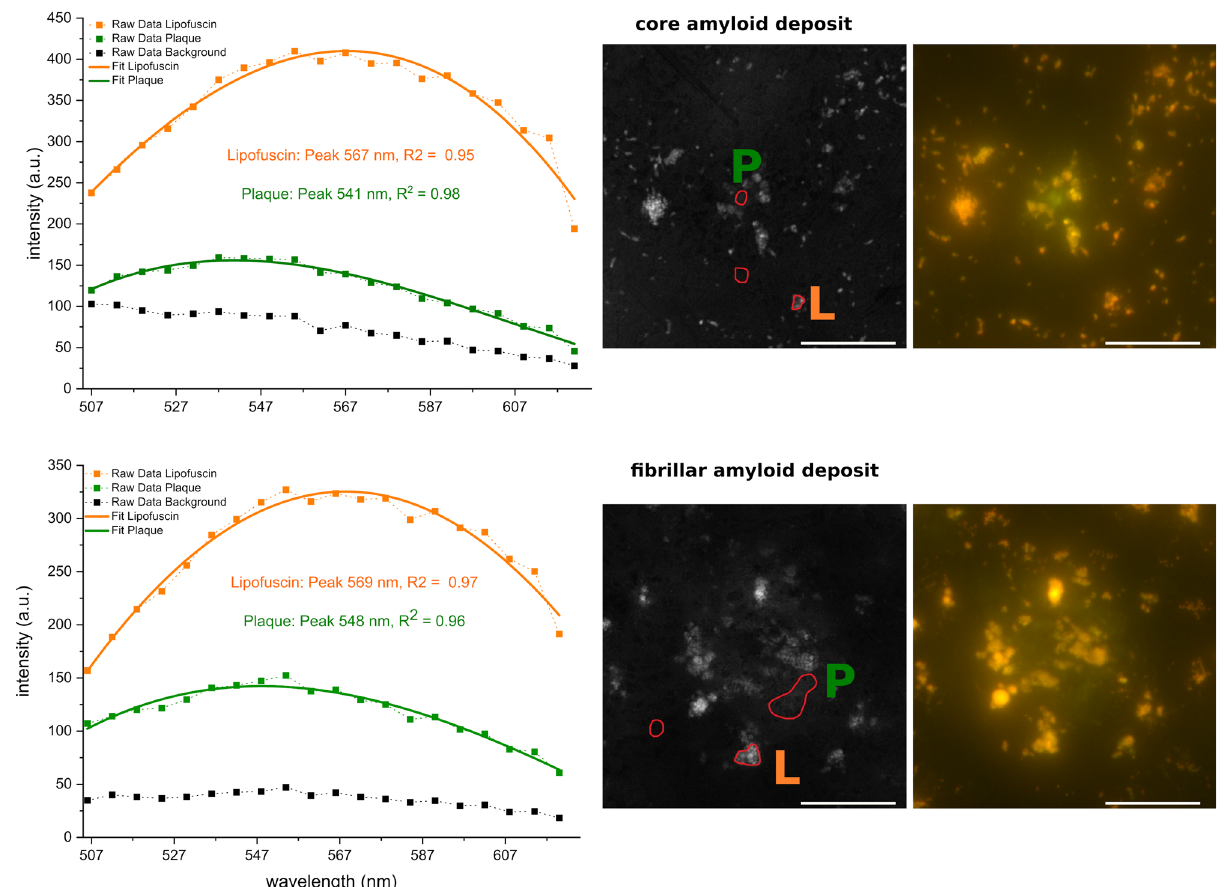
Fig. 4 Fluorescence emission spectra of plaque areas excited with a 488 nm source. Top row: cored amyloid deposit. Bottom: fi brillary amyloid deposit. Symbols connected with a dashed line are the measured data. The solid lines are the corresponding third-order polynomial fi ts; peak position and R 2 values are indicated. The right half shows the corresponding z-projection of the emission images and the locations where the data points for plaque (P), lipofuscin (L), and background were taken, next to it the corresponding full- fi eld auto- fl uorescence images. Corresponding thio fl avin-S images are not shown. Scale bar: 40 µ algorithm subtracts most of the underlying fl uorescence, resulting in a low-intensity Raman spectrum for the lipofuscin spots.